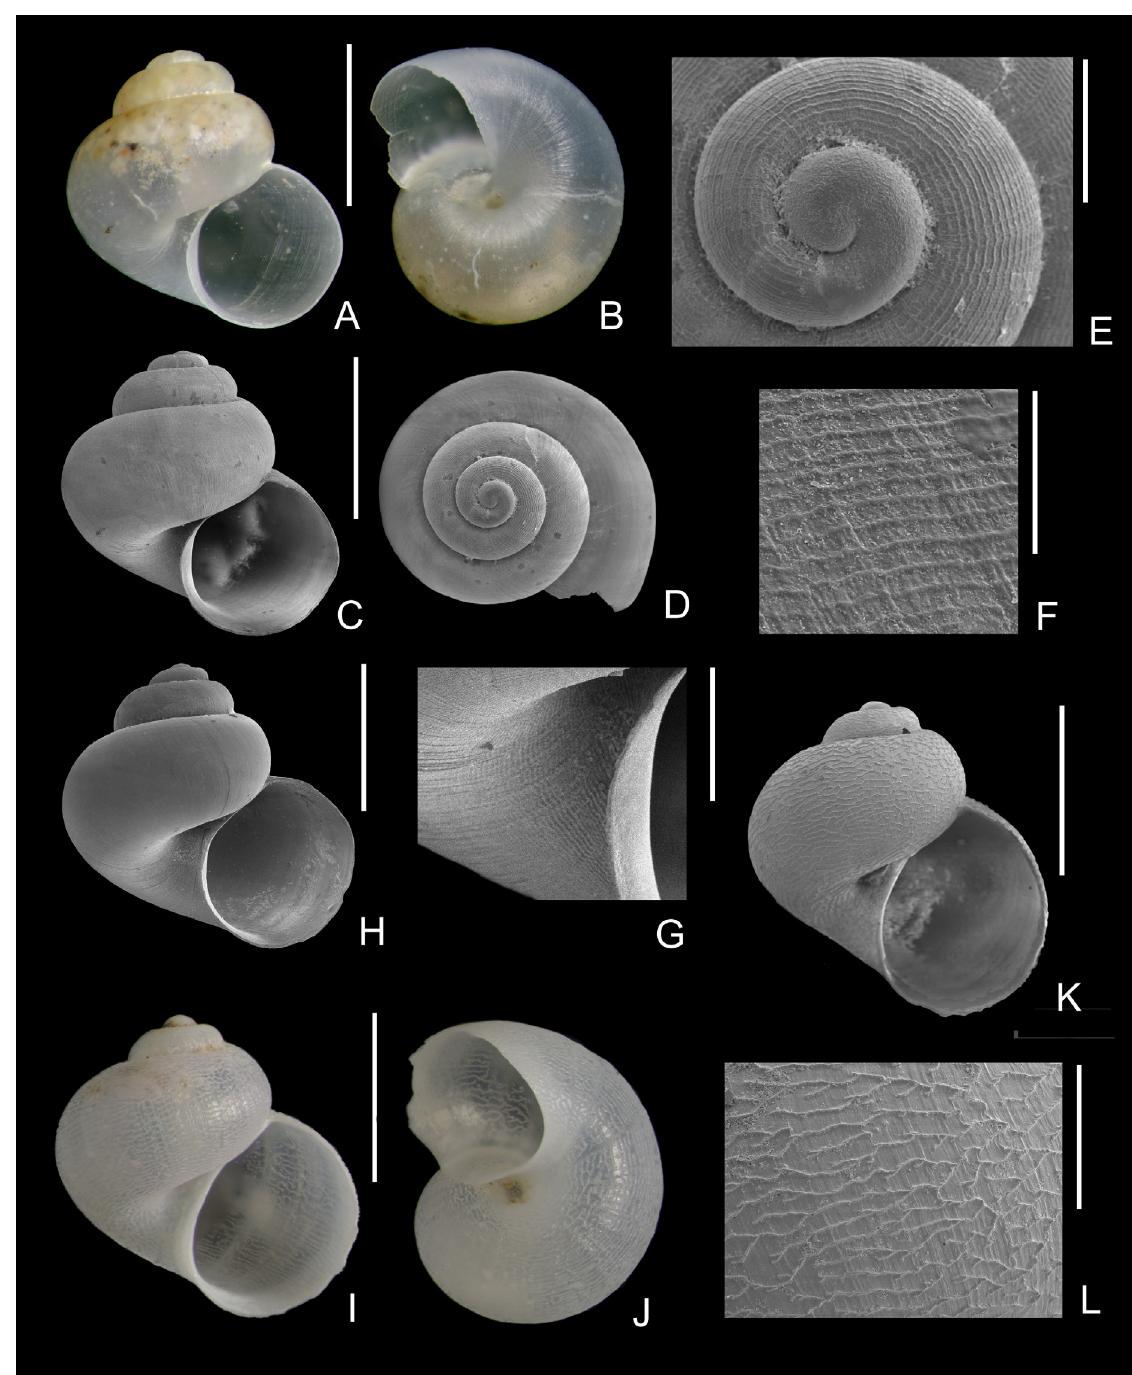
Fig. 17. Skeneimorph species 4. A–H . Anekes spiralis Gofas & Luque sp. nov. A–B . Holotype (MNCN 15.05/200139H), BANGAL 0711, V5, 1631 m, diameter 1.7 mm. C–D . SEM micrograph of the holotype. E . Apical view, protoconch and early teleoconch whorl of the holotype. F . Detail of the microsculpture of the adapical part of the last whorl. G . Detail of the umbilical area of the holotype. H . Paratype (MNCN 15.05/200139P), SEM micrograph, same locality, 2.0 mm. I–J . Granigyra inflata (Warén, 1992), BANGAL 0711, V5, 1631 m, diameter 1.8 mm. K–L . Same shell, SEM micrograph and detail of the microsculpture of the last whorl. Scale bars: A–D, H–K = 1 mm; E, G, L = 200 µm; F = 50